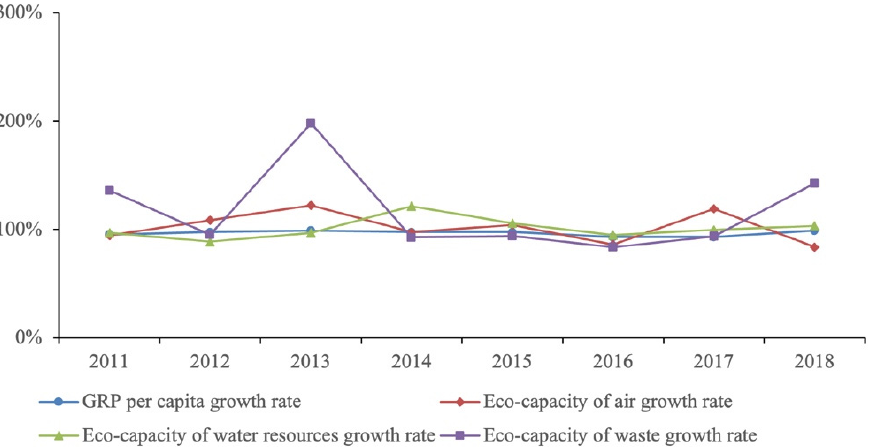
Figure 4. GRP per capita growth rate compared to eco-capacity growth rate in 2010–2018 in RB and Russia (2010 = 100%).